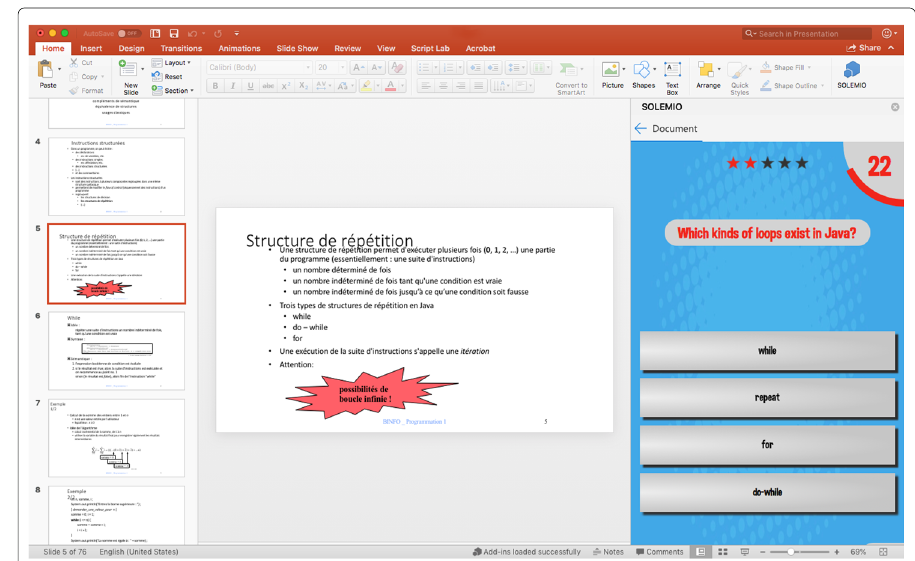
Fig. 7 Example use case of SoLeMiO. Here, a Yactul activity related to the concept of loops can be played from within PowerPoint. Source: (Grévisse et al.